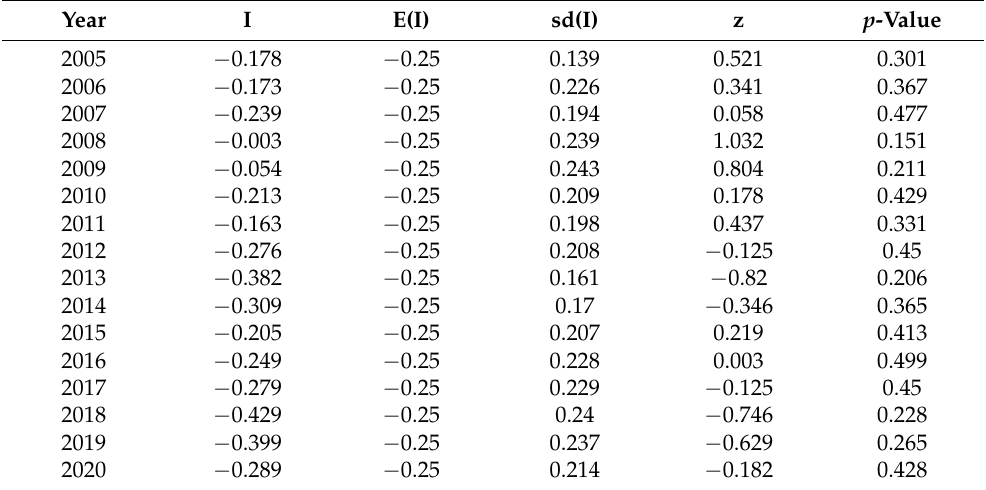
Table 7. Global Moran index of coupling coordination degree in Tarim River Basin from 2005 to